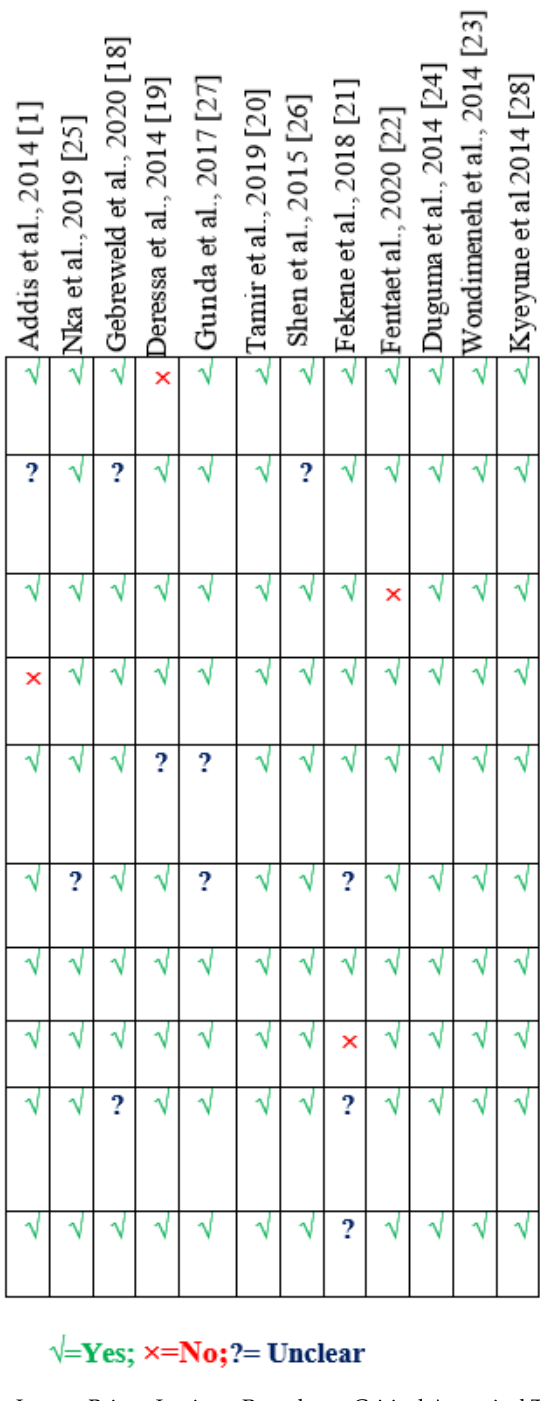
Figure 2. Risk of bias assessment using the Joanna Briggs Institute Prevalence Critical Appraisal Tool.